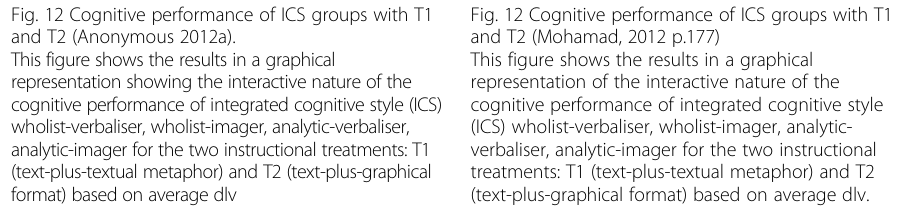
Fig. 12 Cognitive performance of ICS groups with T1 and T2 (Anonymous 2012a).